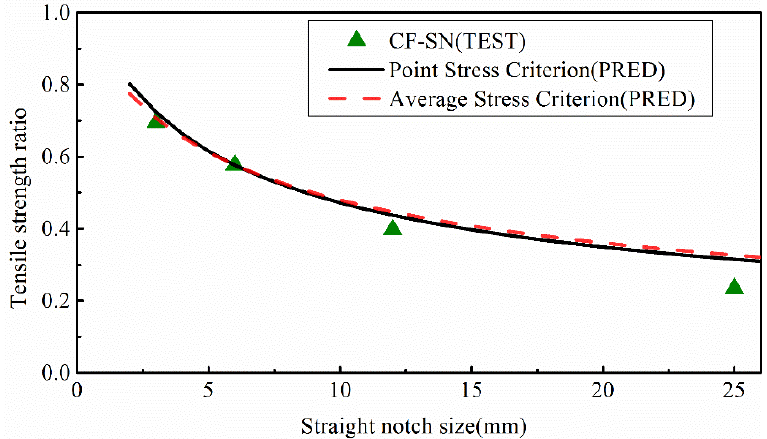
Figure 23. Comparison of the tensile strength ratio curves of the equal specimen size group predicted by the point stress criterion and average stress criterion in the WN stress criteria with test results; the predicted results are not in good agreement with the experimental results when W /2 C < 6.